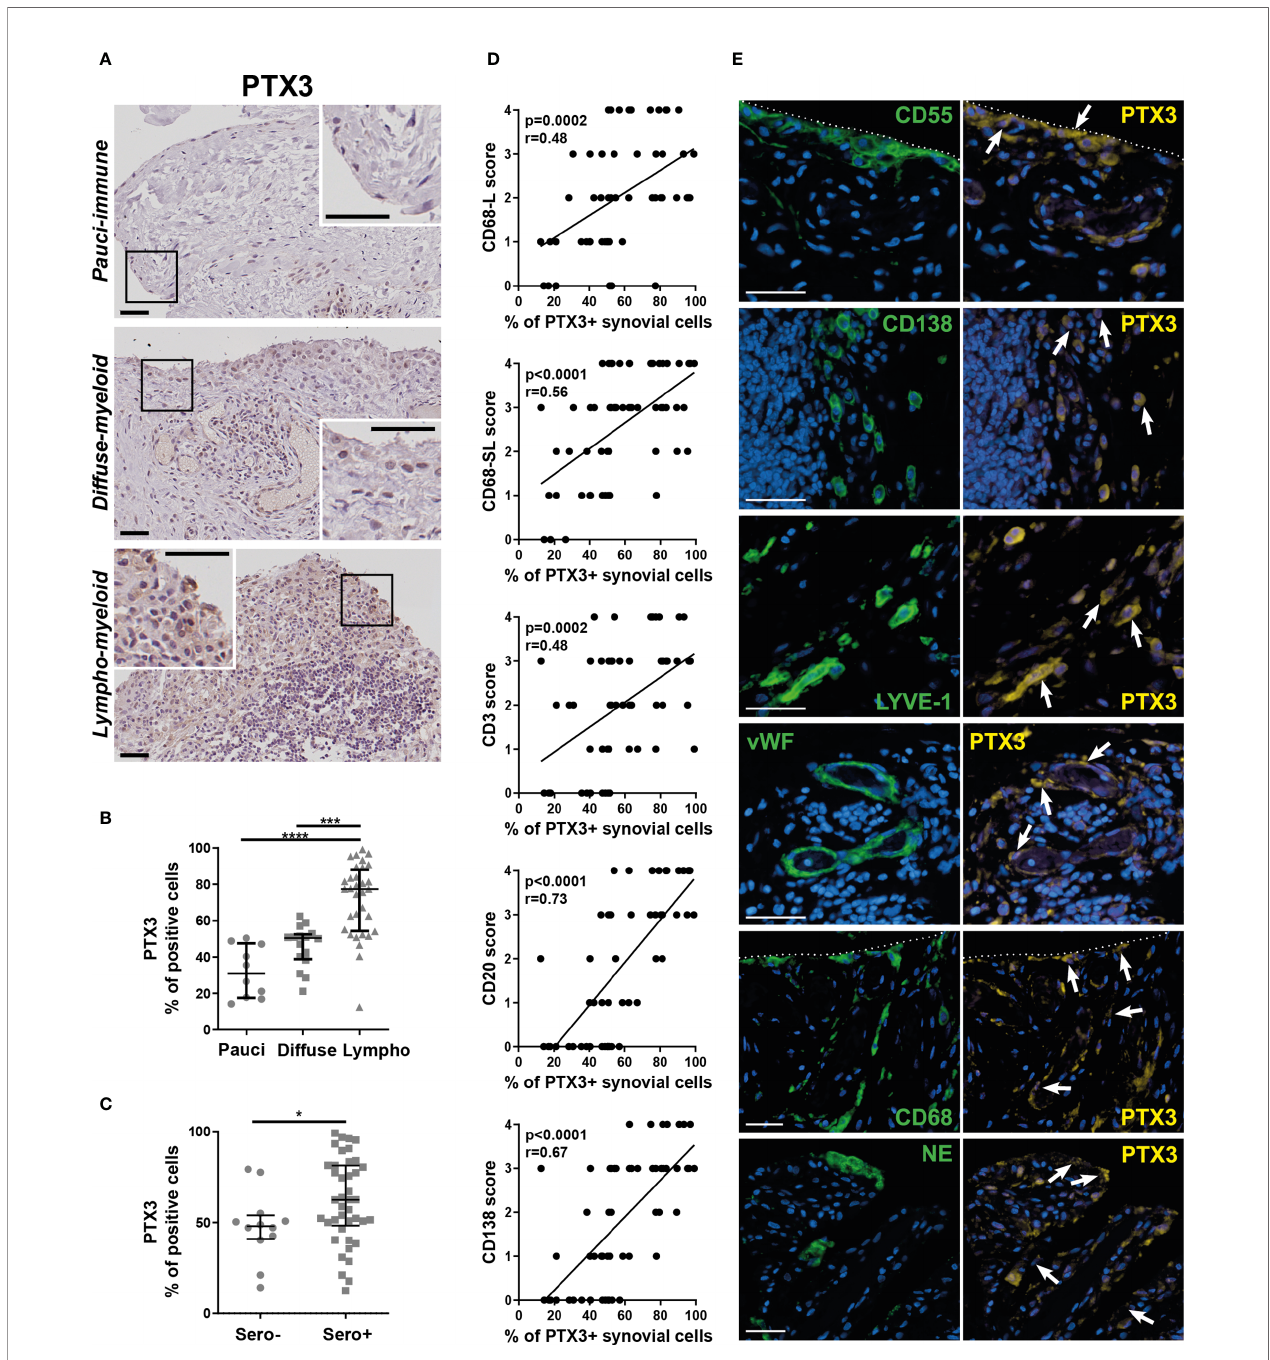
FIGURE 3 | Synovial PTX3 expression associates with immune cell in fi ltration and the presence of ectopic lymphoid structure. (A) Sections of RA synovium were stained for PTX3. Representative images are shown for each pathotype (pauci-immune, diffuse-myeloid and lympho-myeloid). Scale bar = 40 m m. (B) Digital image analysis was performed on RA synovium sections (n = 58) classi fi ed as pauci-immune (n = 10), diffuse-myeloid (n = 16) and lympho-myeloid (n=32). Synovial PTX3+ cells quanti fi cation was determined using QuPath software (28). ***p < 0.001, ****p<0.0001, as assessed by the Kruskal – Wallis test with Dunn ’ s post-test. (C) % of PTX3 positive cells in rheumatoid factor (RF)/cyclic citrullinated peptide (CCP) seropositive/negative patients. *p<0.05, as assessed by the Mann Whitney test. Data are represented as median +/- interquartile range. (D) Correlation between the percentage of PTX3 positive cells and the semi-quantitative scores for in fl ammatory cells markers (CD3-T cells; CD20-B cells; CD138-plasma cells; CD68L-macrophages of the synovium lining layer; CD68SL-macrophages of the sublining layer) (2, 3). p-values were calculated using Pearson correlation test. (E) Double immunostaining of PTX3 (yellow) with CD55, CD138, LYVE-1, vWF, CD68 and NE (green) in the synovium of RA patients. Nuclei were counterstained with DAPI (blue). White arrows indicate double-positive cells. Representative images are shown. Scale bar = 40 m